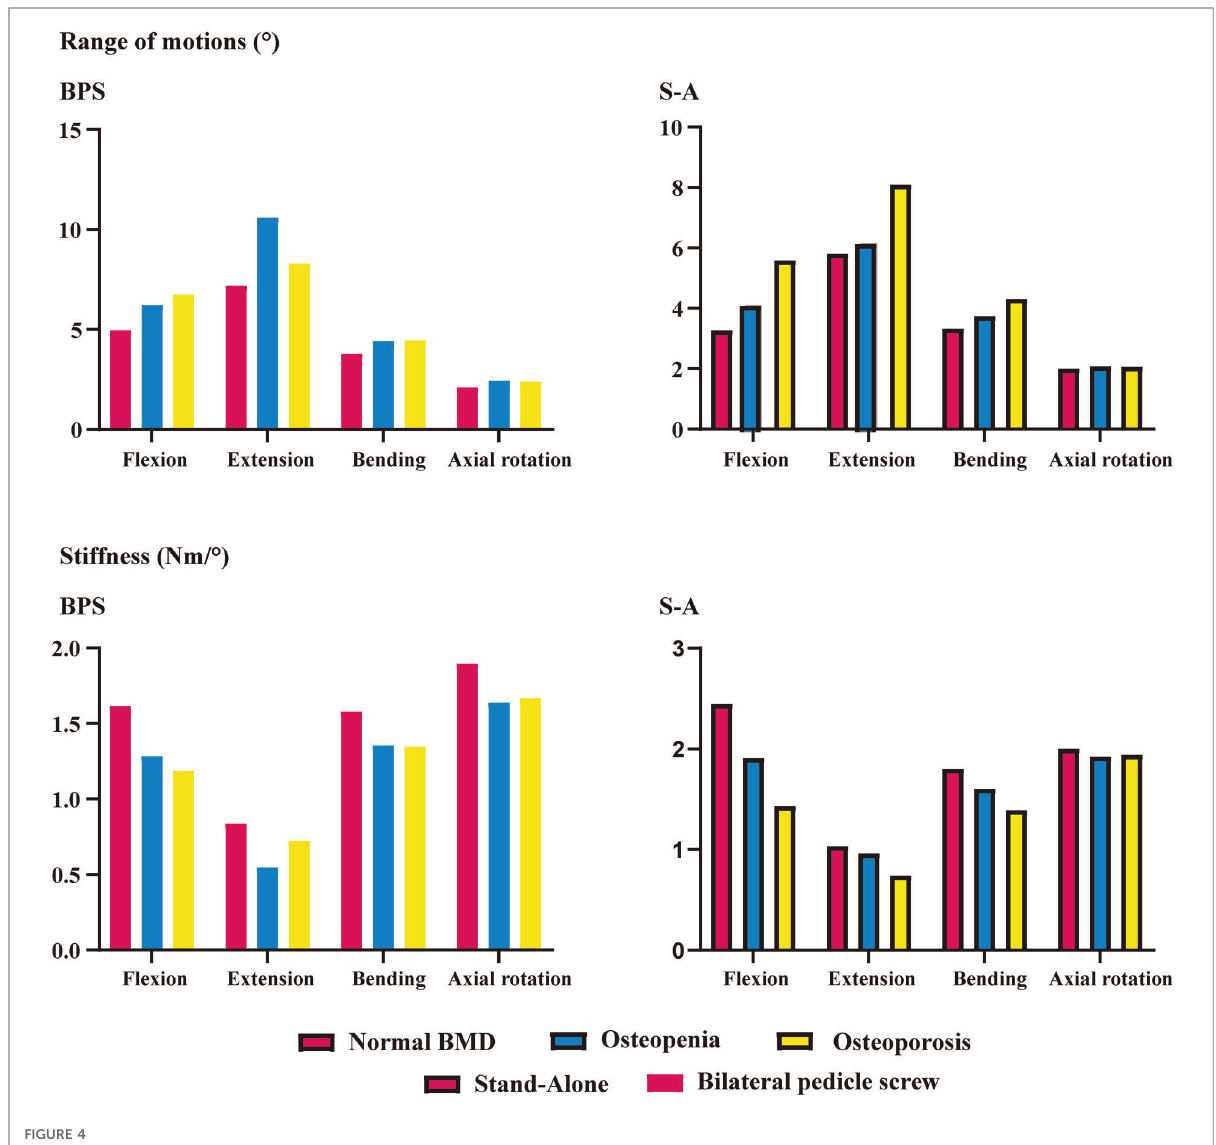
FIGURE 4 ROMs and stiffness of the surgical segment (L4 –